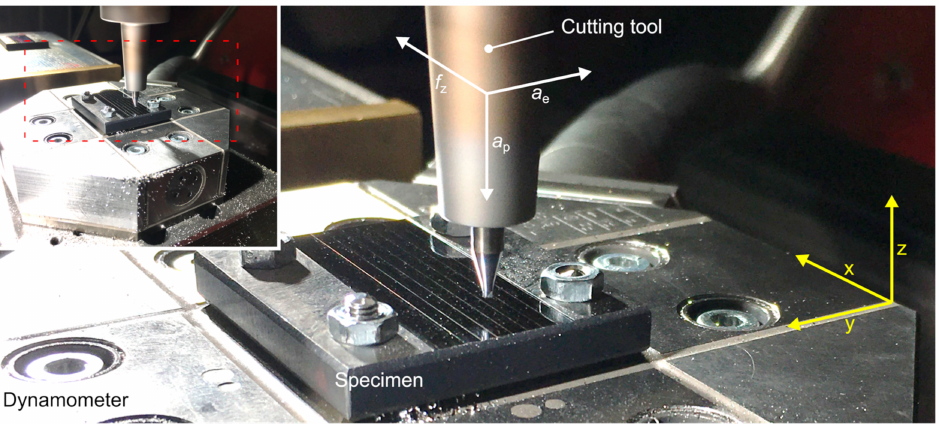
Figure 5. Experimental